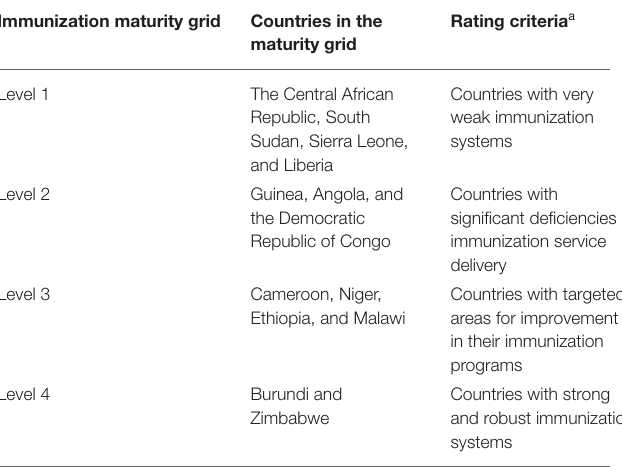
TABLE 3 | Classification of countries according to their immunization maturity grid.